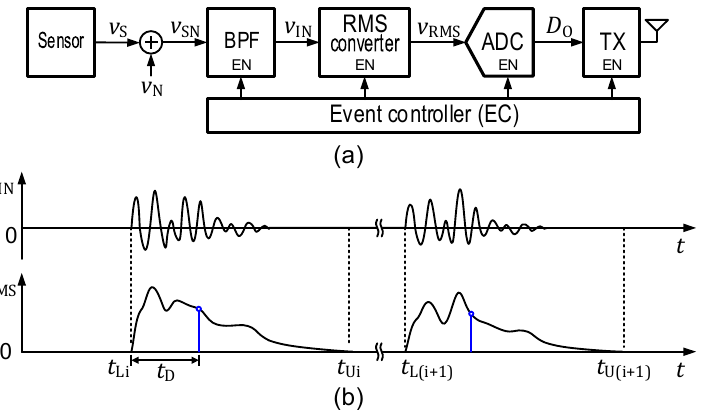
Figure 5. Conventional monitoring system with proposed event controller (EC). ( a ) Block and ( b ) timing diagrams, with sampling time delay t D .